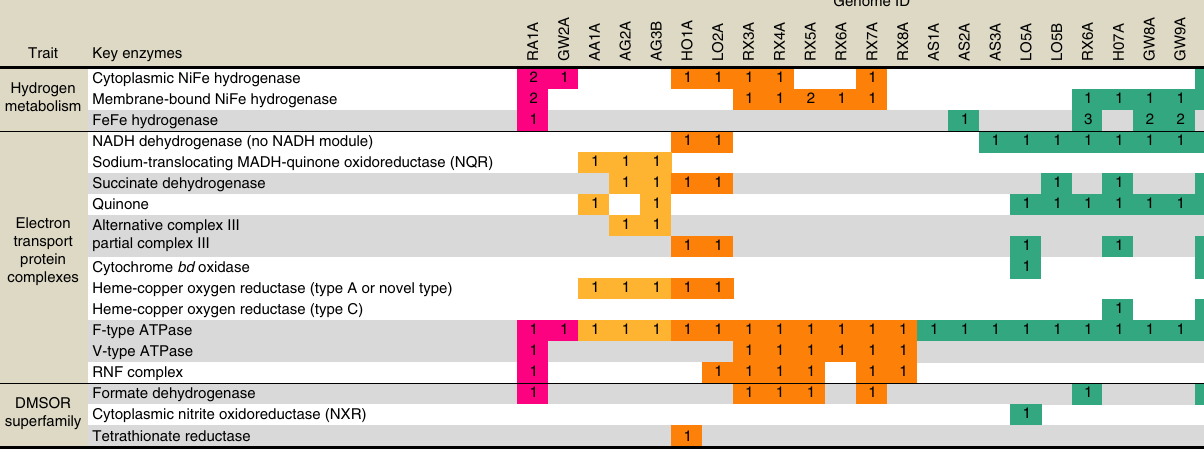
Fig. 8 Key enzymes involved in H 2 and